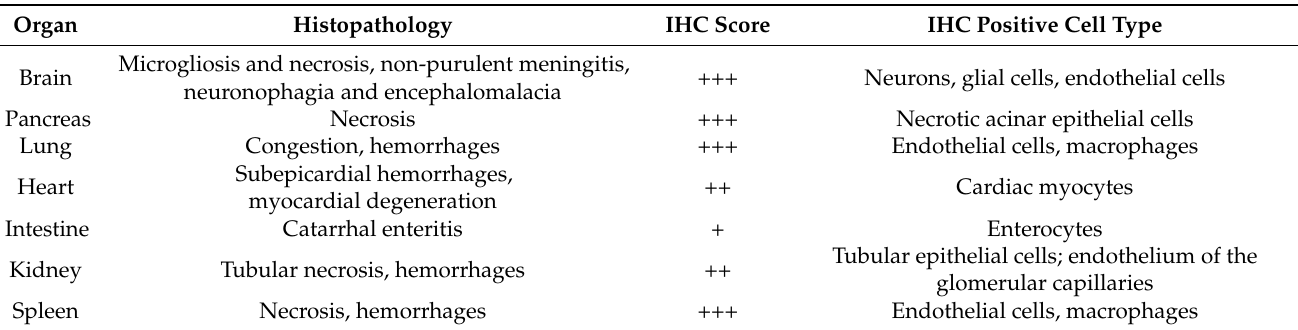
Table 1. Histopathological changes and average distribution of viral antigen–positive cells in tissues sampled from domestic chickens naturally infected with the HPAI H5N8